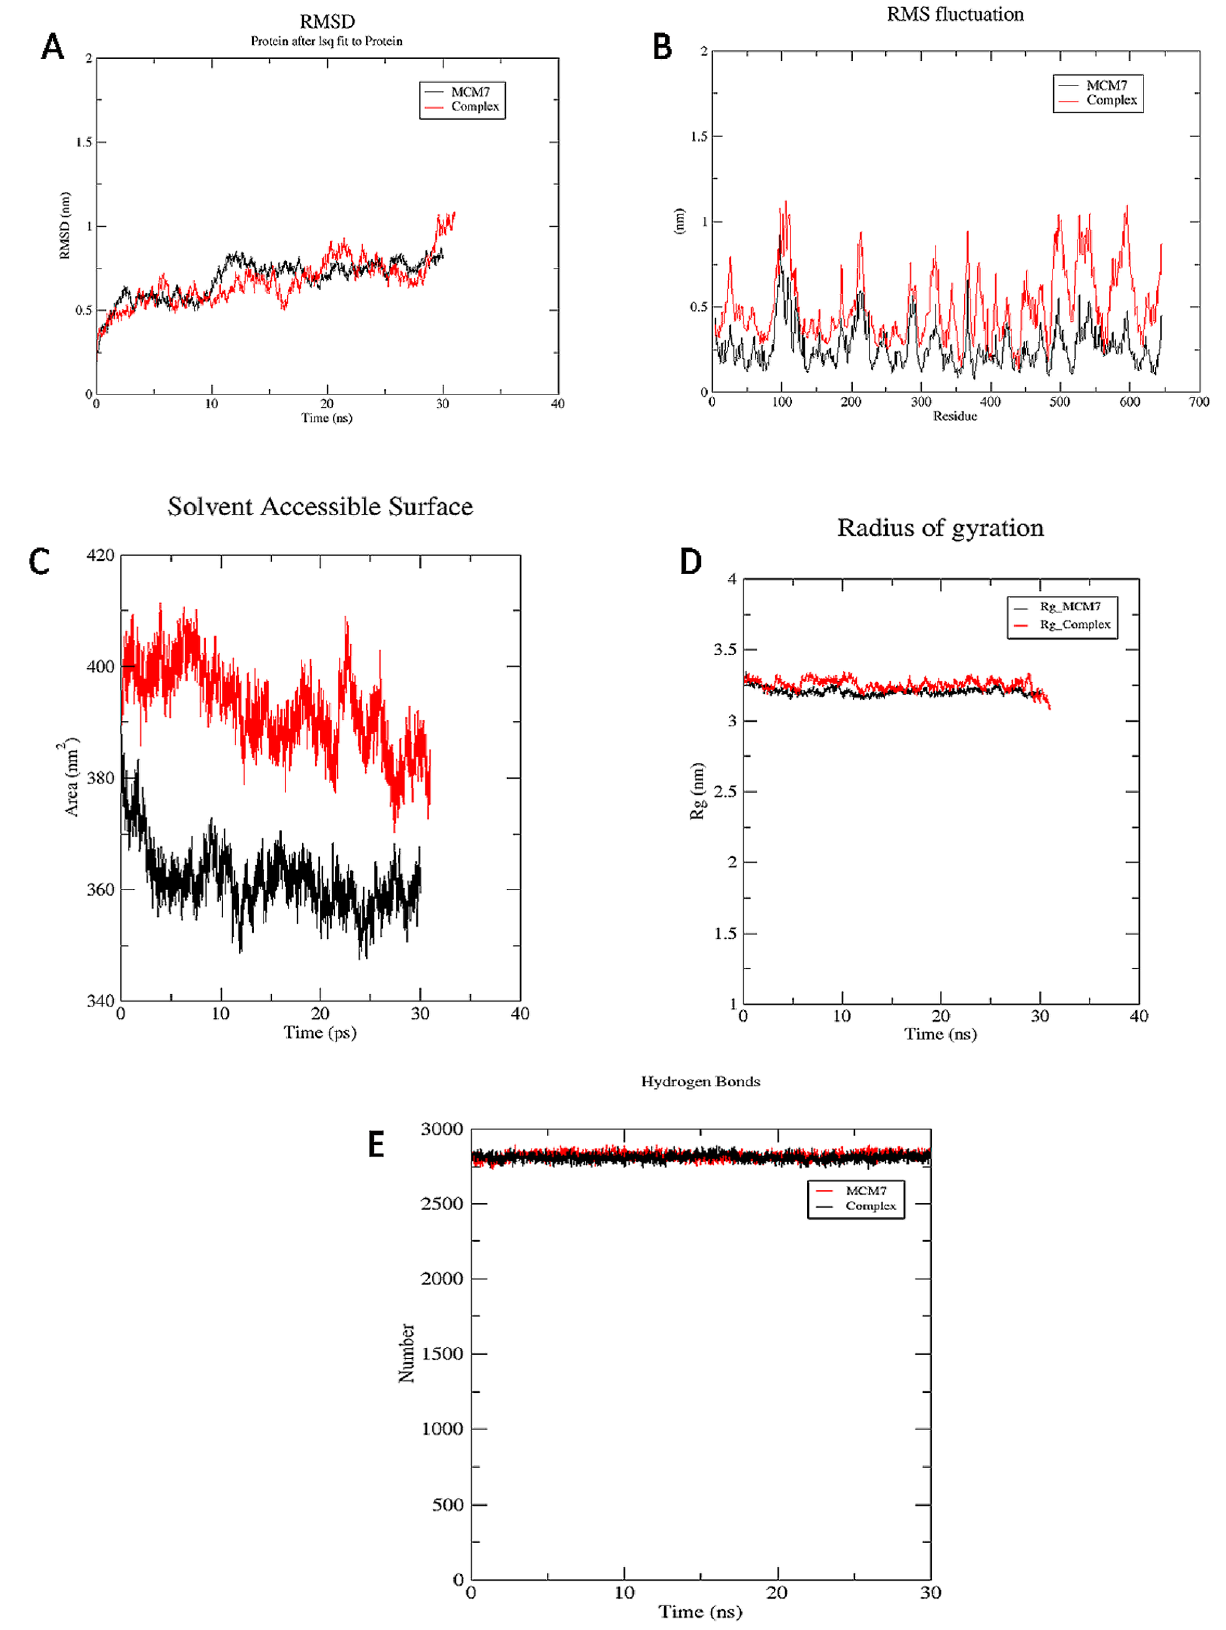
Figure 5. MD simulation studies of MCM7 (represented in black color) and the complex of MCM7 with UEFS99 (represented in red color). ( A ) RMSD, ( B ) RMSF, ( C ) SASA, ( D ) radius of gyration, ( E ) hydrogen bonds.